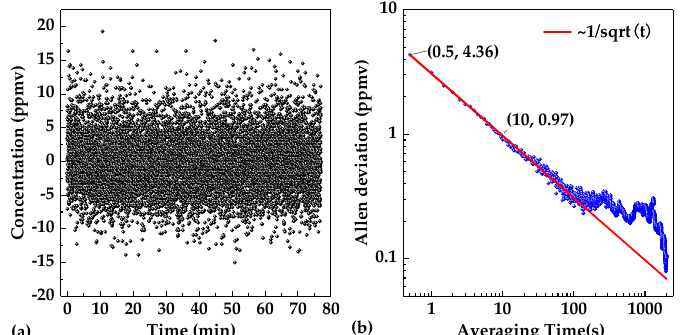
Figure 12. ( a ) C 2 H 2 concentration measurements of the sample with zero concentration for a time period of > 1 hour. ( b ) Allan deviation plot of the C 2 H 2 sensor with a sampling interval of 0.5 s based on the data shown in Figure 12a.